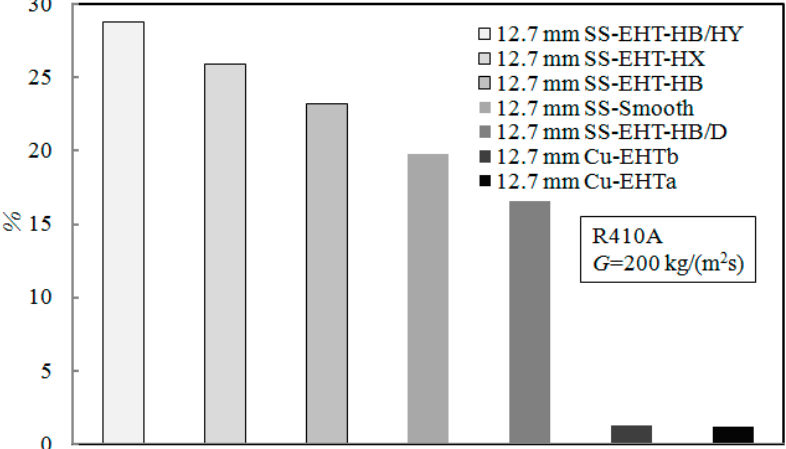
Figure 9. Comparison of thermal resistance (for various tube types based upon data obtained in this study) to total evaporation thermal resistance for 12.7 mm OD tubes.